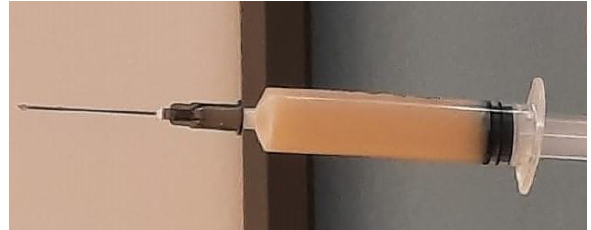
Figure 6. Sample of the fluid drained from the